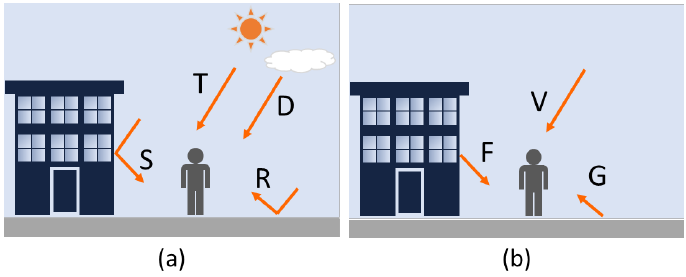
Figure 1. Energy components of R abs that stem from ( a ) solar radiation and ( b ) radiant heat. Table 1 . Primary input parameters for each energy component.